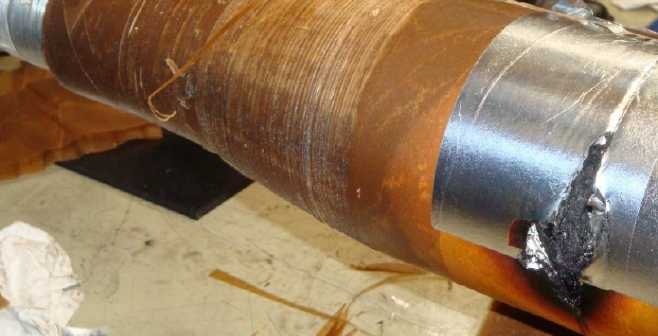
Figure 1. Example of a failure in the paper-oil insulation system of a 220 kV insulator bushing due to uncontrolled development of surface PD.